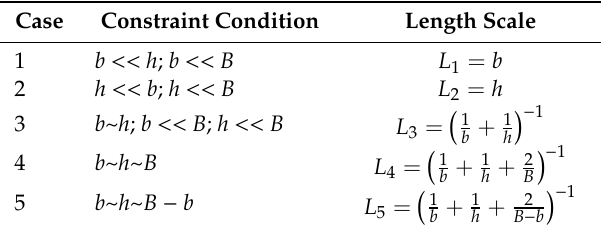
Table 1. Summary of five length scale